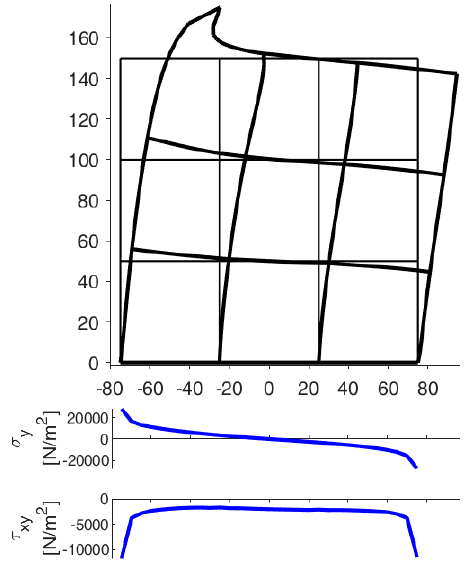
Figure 19. Deformed configurations of the nine discrete elements and stress analysis on the lower constrained sides (the y -axis runs vertically), after 15 top-to-bottom-to-top stabilization cycles on the rows (Thin line: undeformed configurations. Thick line: deformed configurations. Amplification factor of the displacements: k = 200 ).